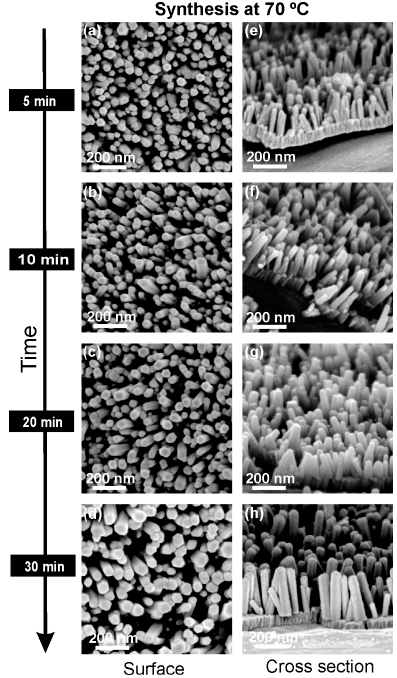
Figure 1. Surface and cross-section scanning electron microscopy (SEM) images of ZnO nanorods produced by the hydrothermal method assisted by microwave radiation at 70 °C, with different synthesis times on cardboard substrate: ( a , e ) 5 min; ( b , f ) 10 min; ( c , g ) 20 min; ( d , h ) 30 min.